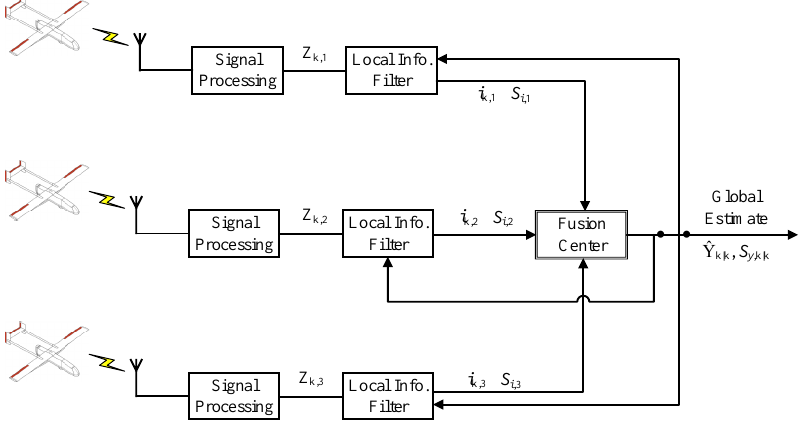
Figure 3. During a search and rescue (SAR) mission, multiple UAVs track a target with centralized distributed measurement information broadcasted to the control center (CC) for information estimate implementation. In this configuration, communication is allowed between each UAV and the